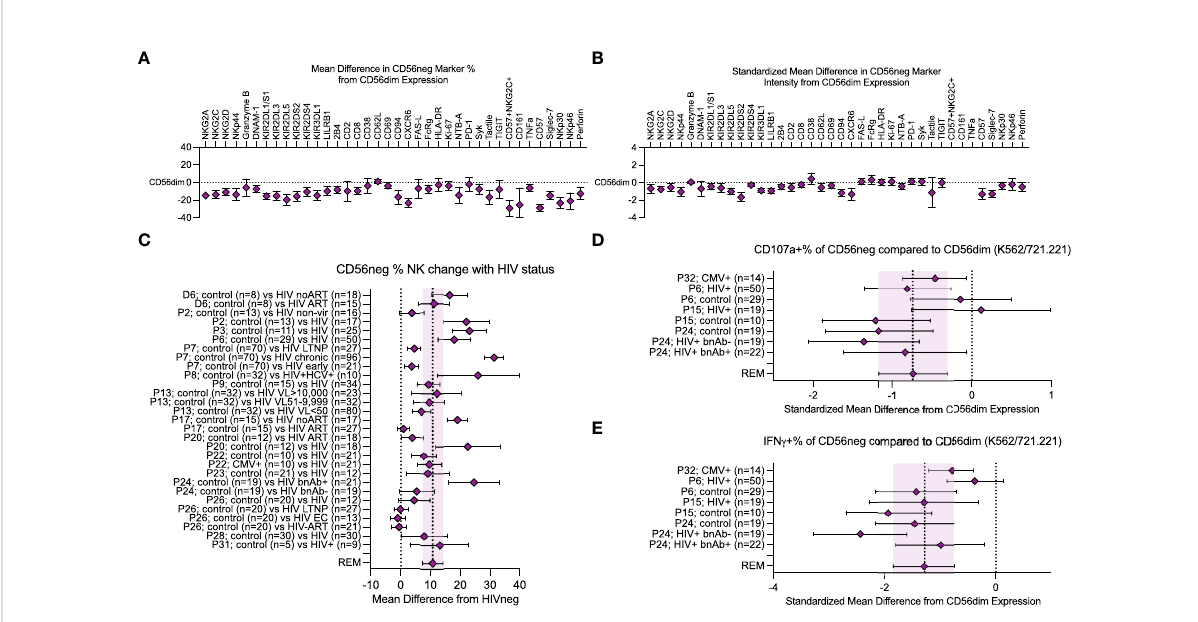
FIGURE 2 Meta-analysis of CD56neg subset frequency in HIV-1 + individuals, and variation in phenotype and function. (A) combined mean difference in CD56neg subset frequency of markers compared to paired CD56dim cells are shown at zero. (B) combined standardized mean difference in expression intensity for marker expressing CD56neg cells in comparison to the CD56dim subset. (C) mean difference of CD56neg % NK cells in peripheral blood in HIV-1 + groups from HIV-1 - controls (REM mean difference 10.69%, CI ± 3.34, I2 = 95%; study n = 15, dataset n = 1, combined HIV-1 + samples n = 751, combined HIV-1 - samples = 354). (D, E) show the standardized mean difference (SMD) in CD56neg NK cell CD107a and IFN g responses to HLA-negative target cells compared to CD56dim cells (CD107a REM SMD -0.74, CI ± 0.42, I2 = 54%, IFN g REM SMD -1.29, CI ± 0.54, I2 = 73%; study n = 4, combined sample n = 182). Data are presented as mean and 95%